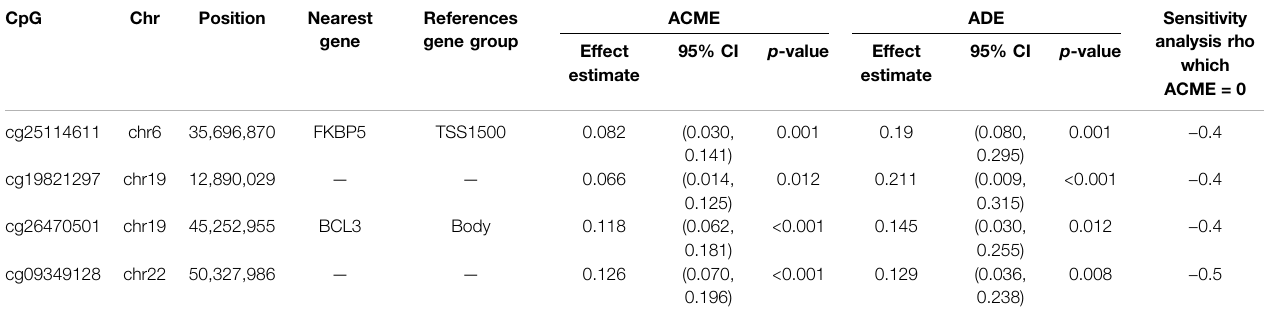
TABLE 5 | Mediation analysis on candidate CpGs between smoking and